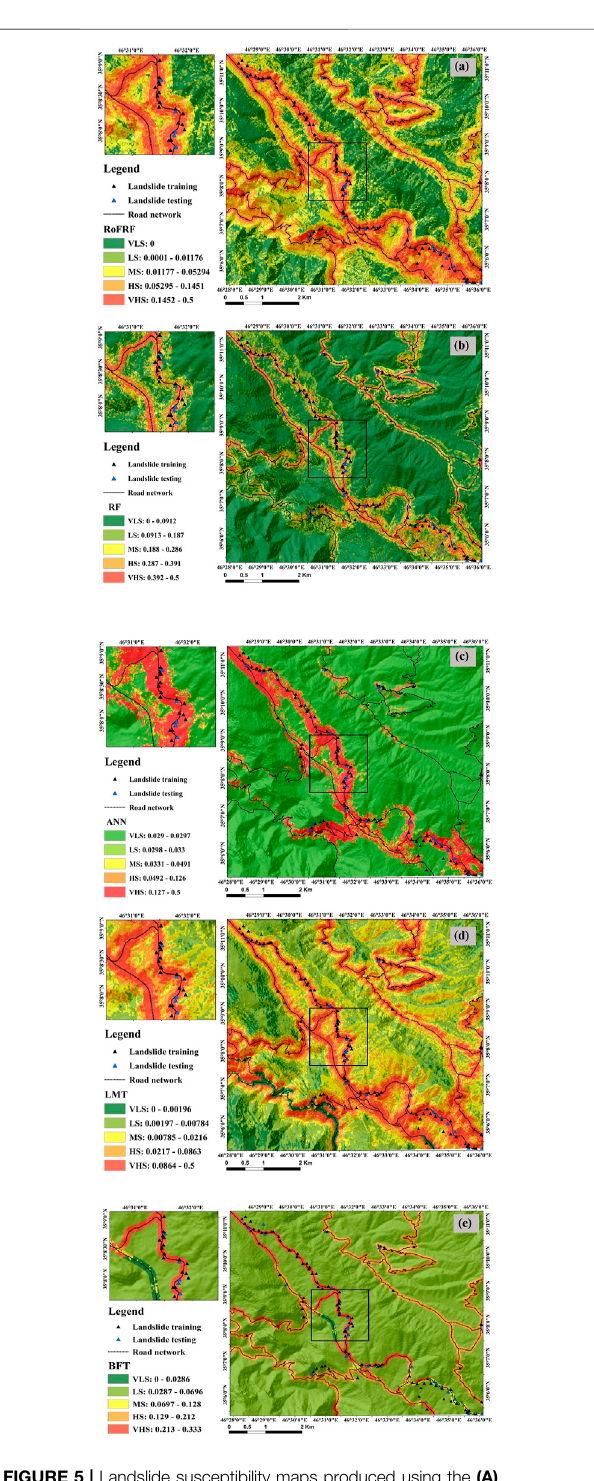
FIGURE 5 | Landslide susceptibility maps produced using the (A) RoFRF, (B) RF, (C) ANN, (D) LMT, and (E)